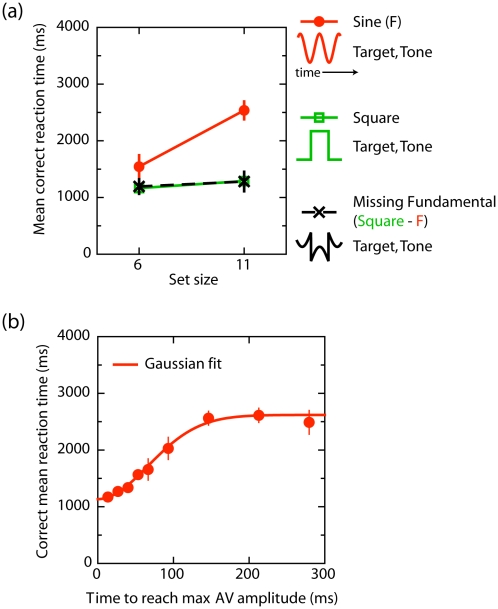
Results of Experiment 4.A) Mean correct reaction time (RT) as a function of set size for each stimulus type. B) Mean correct reaction time (ms) as a function of steepness. The steepness refers to the time to reach the maximum amplitude from its minimum (or vice versa). Note that 13 ms reflects a square-wave modulation. These data show that auditory driven search requires abrupt auditory and visual events.